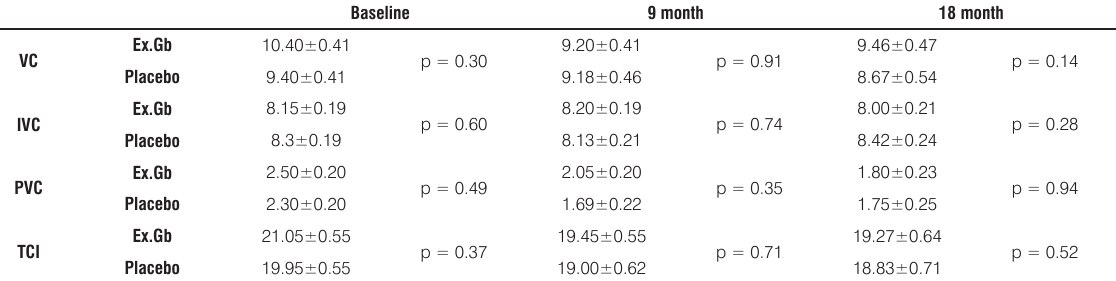
Figure 1. Changes of the total conjunctival index at baseline, after 9 and 18 months in both groups TCI significantly decrease by 1,6 point after 9 months (p = 0.043) and by 1.78 point after 18 months (p = 0.037) as compared with baseline in Ex.Gb group. While the changes of TCI in placebo group were not significant: 0.95 point after 9 month (p = 0.254) and 1.12 point after 18 months (p = 0.219) as compared with baseline. Table 3. Mean of oxidative stress parameters at baseline, after 9 and 18 months in both